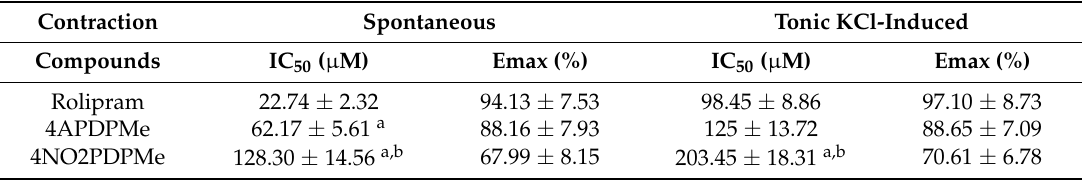
Table 1. Rolipram and thalidomide analog IC 50 and Emax values for myometrial spontaneous and tonic contractions.